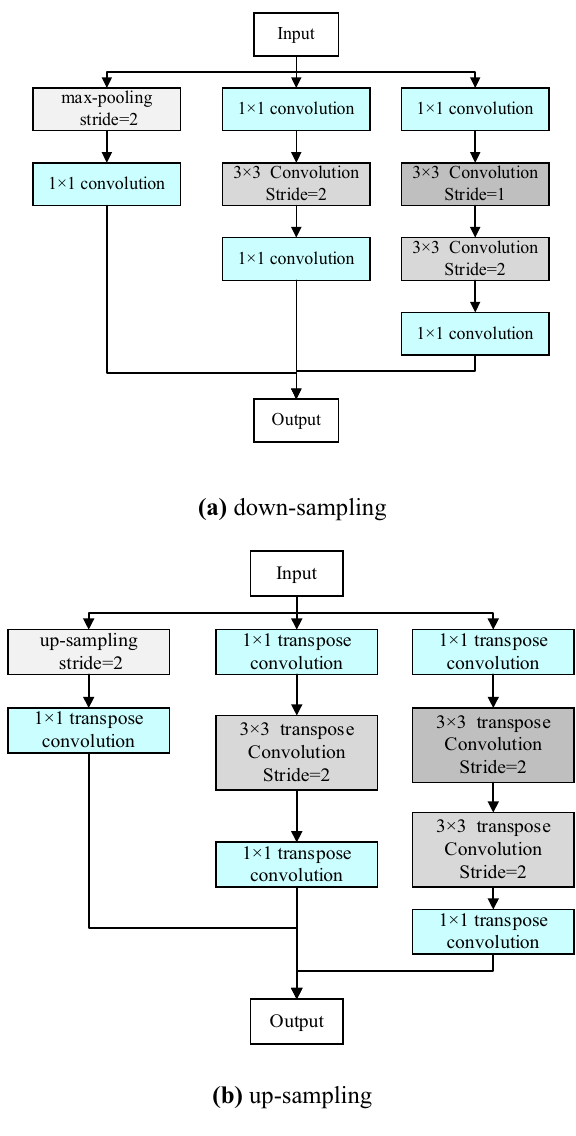
Fig. 5 Down-sample and up-sample block ( a down-sample block; b up-sample